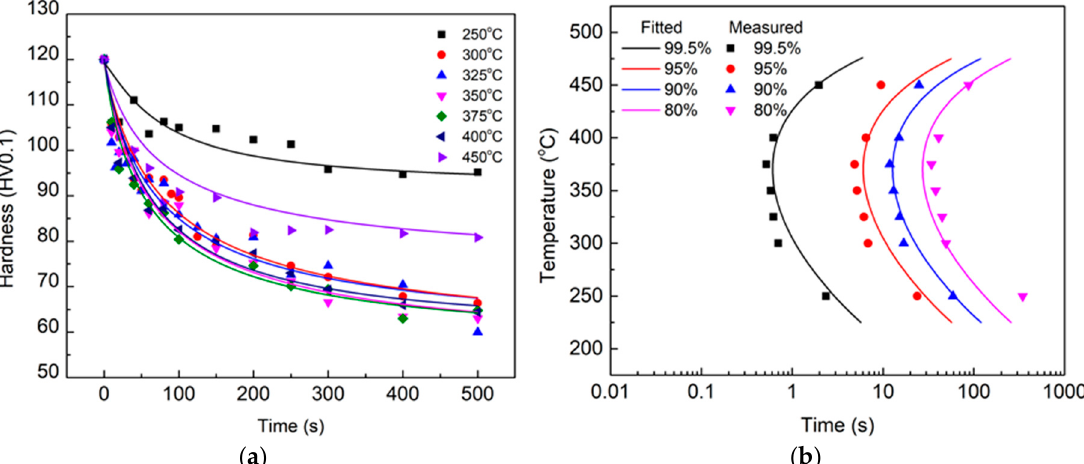
Figure 3. Effect of isothermal treatment on microhardness of quenched HPVD casting samples ( a ); respective time–temperature–property (TTP) diagram ( b ).